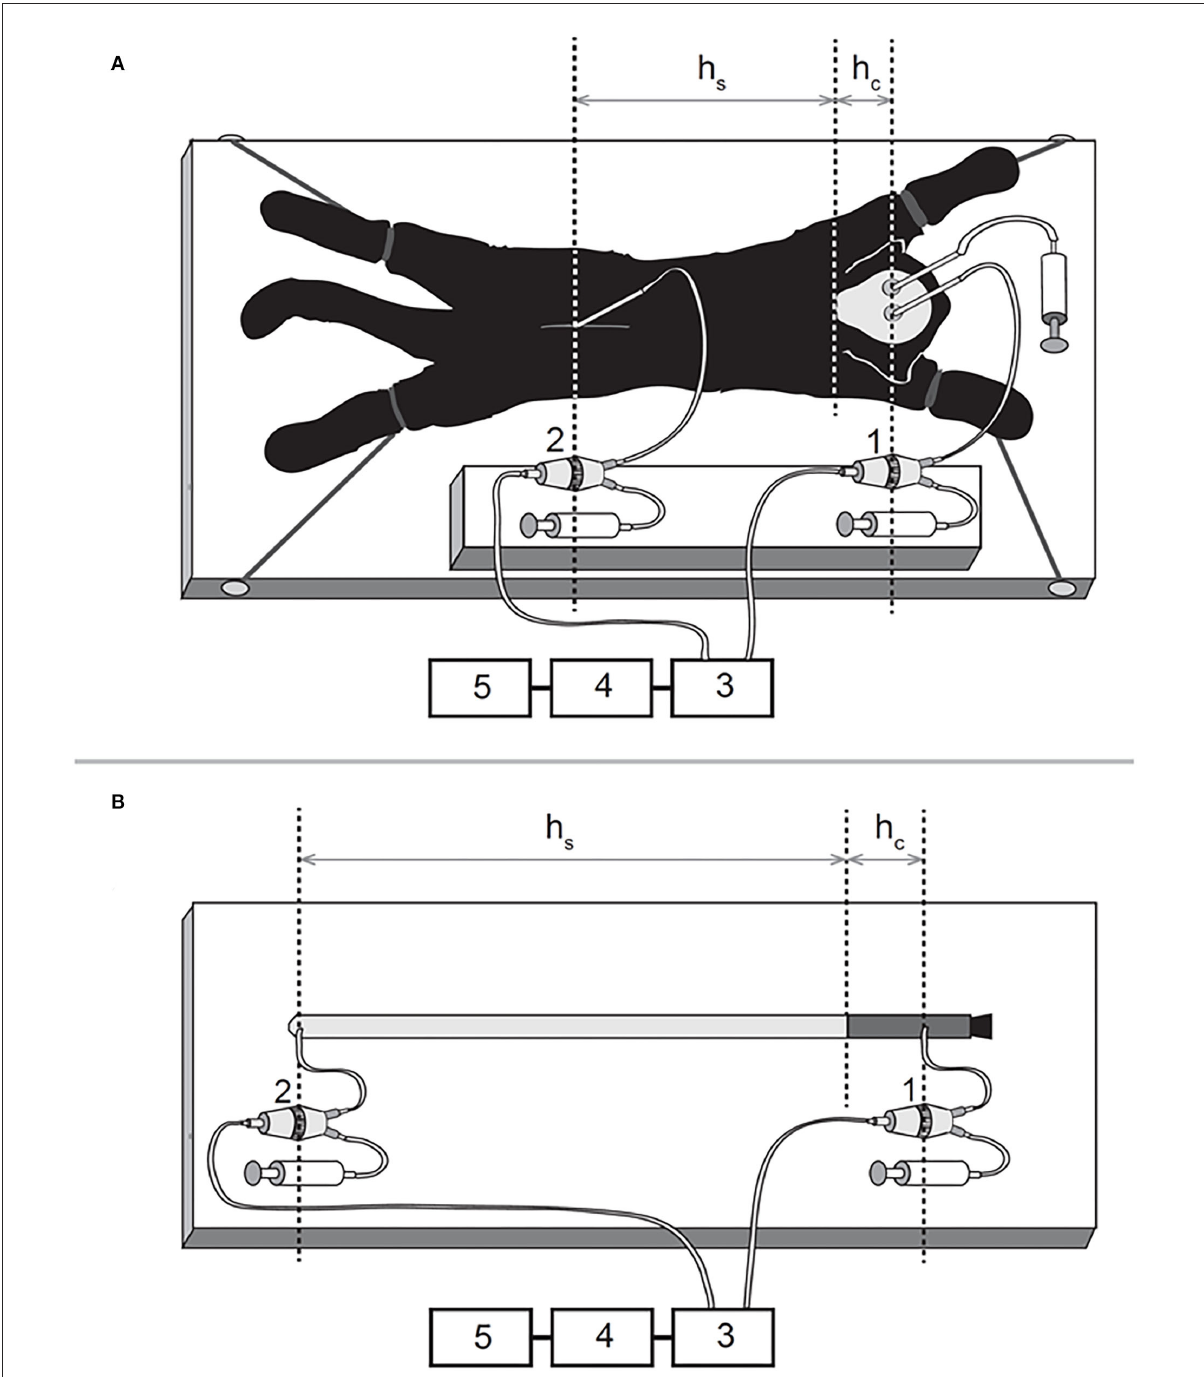
FIGURE1 Schematic representations of the experimental models on a cat (A) and phantom (B) in horizontal position 1, pressure transducer connected to the cannula inside the lateral ventricle; 2, pressure transducer connected to the cannula inside the lumbar subarachnoid space; 3, Quand Bridge; 4, PowerLab/800; 5, personal computer; hc, the distance between the cisterna magna and the pressure measuring point inside the lateral ventricle; hs, the distance between the cisterna magna and the pressure measuring point inside the lumbar subarachnoid space.